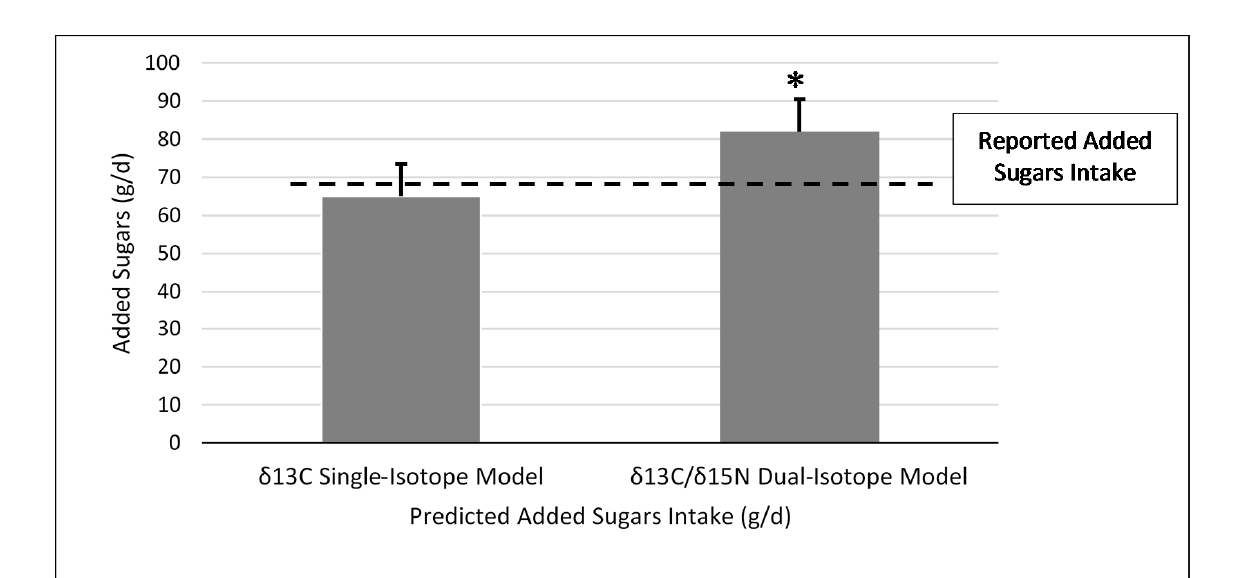
Figure 1. Reported added sugars intake compared to predicted added sugars intake for the δ 13 C single-carbon and δ 13 C and δ 15 N dual-carbon and nitrogen stable isotope ratio prediction models in the test group ( n = 56) . * Significant difference between reported added sugars intake and dual-isotope model at p = 0.02. δ 13 C and δ 15 N dual-isotope model (mean difference ± standard error = 13.0 ± 5.4 g; Z = − 2.95; p = 0.003). No significant difference was found between reported added sugars intake and predicted added sugars intake for the δ 13 C single-isotope model (mean difference ± standard error = − 3.6 ± 5.5 g; Z = − 0.55, p =